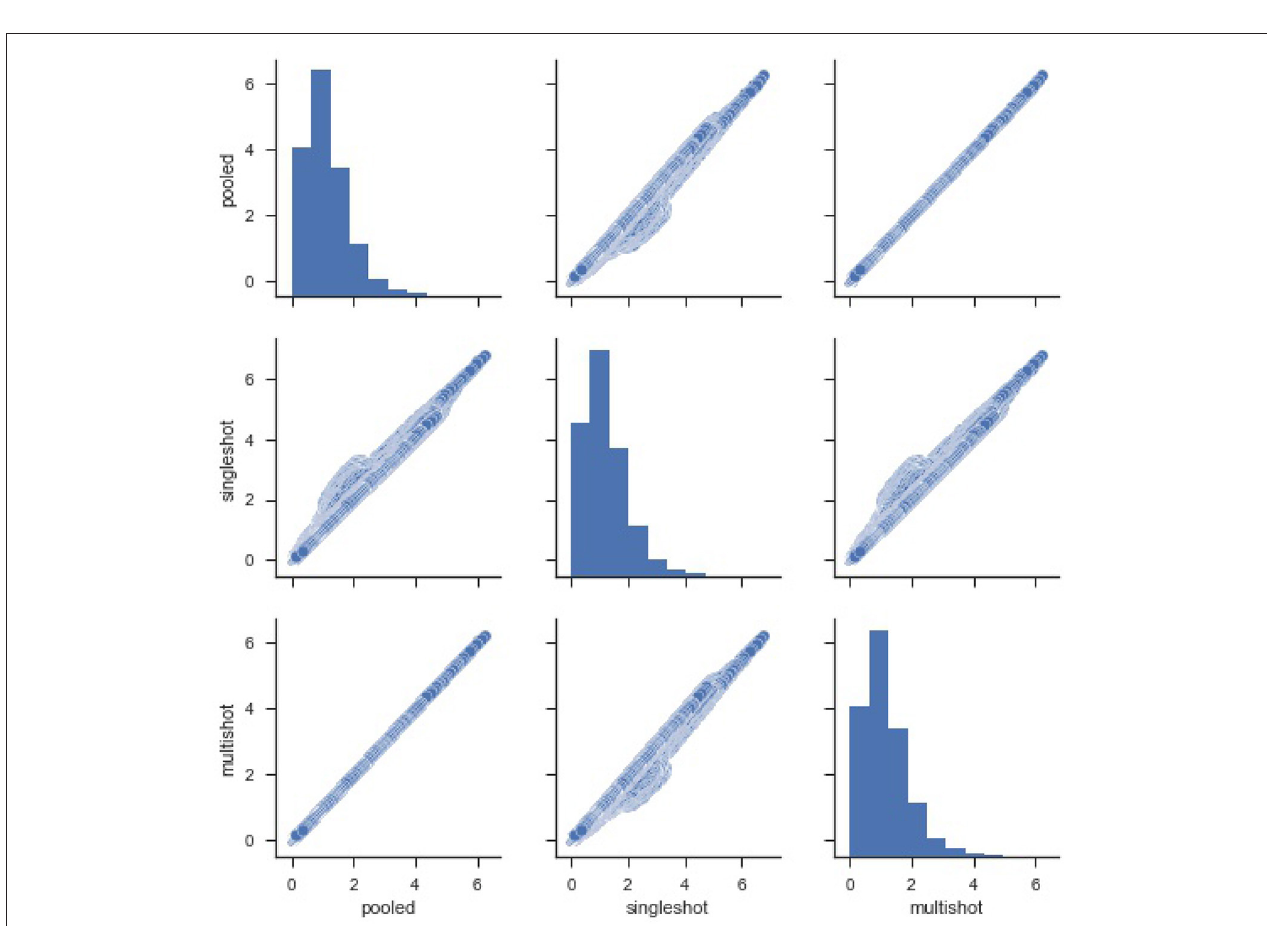
FIGURE 1 | Pairwise plot of Sum Square of Errors (SSE) from pooled, single-shot and multi-shot regression. Although the distribution plot looks similar across the three regressions, the pooled regression vs. multi-shot regression scatter plot demonstrates how identical they are to each other.The scatter plot of pooled regression vs. single-shot regression demonstrates that the SSE values obtained from singles-shot regression are on the higher side compared to the values from pooled regression.